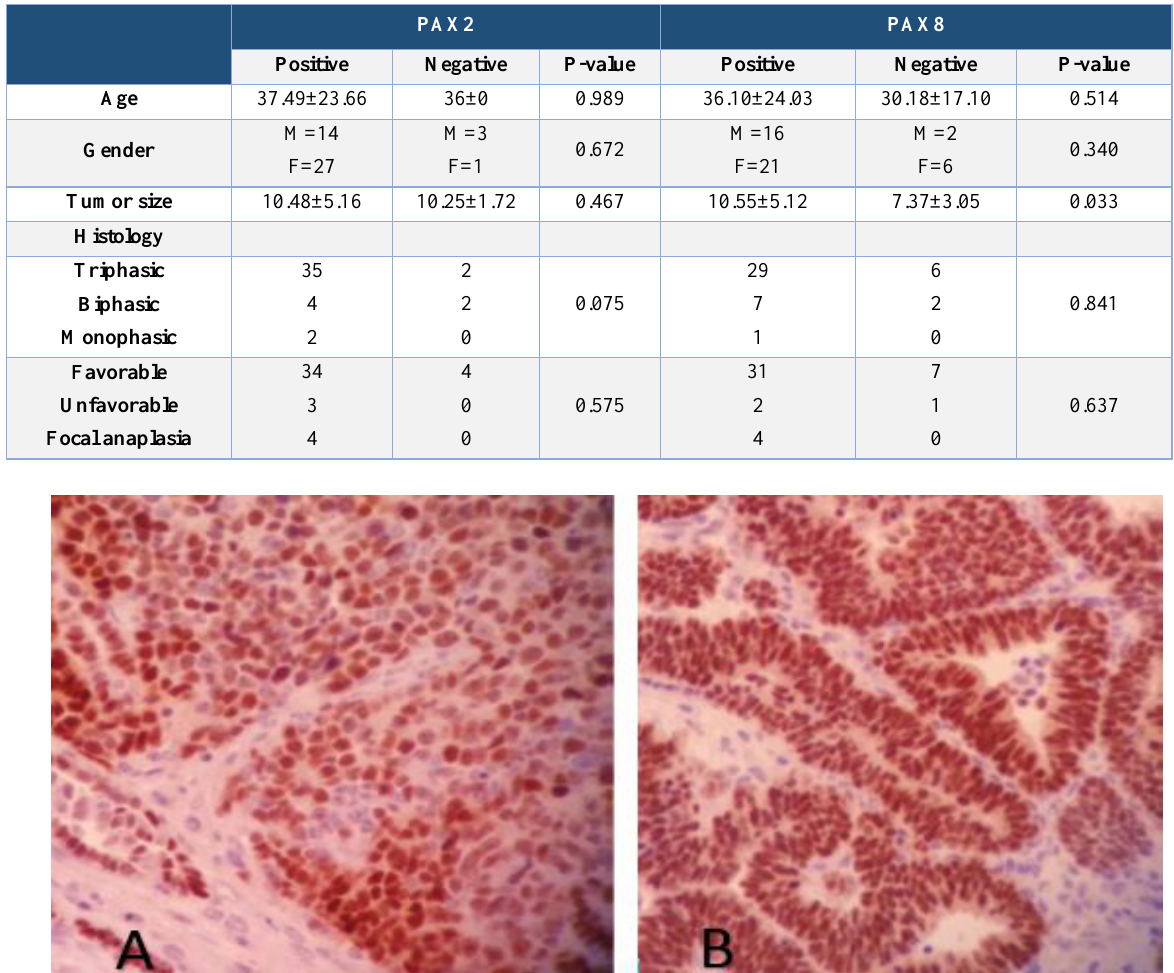
Table 2 . PAX2 and PAX8 expression in comparison with demographic data and tumor characteristics.